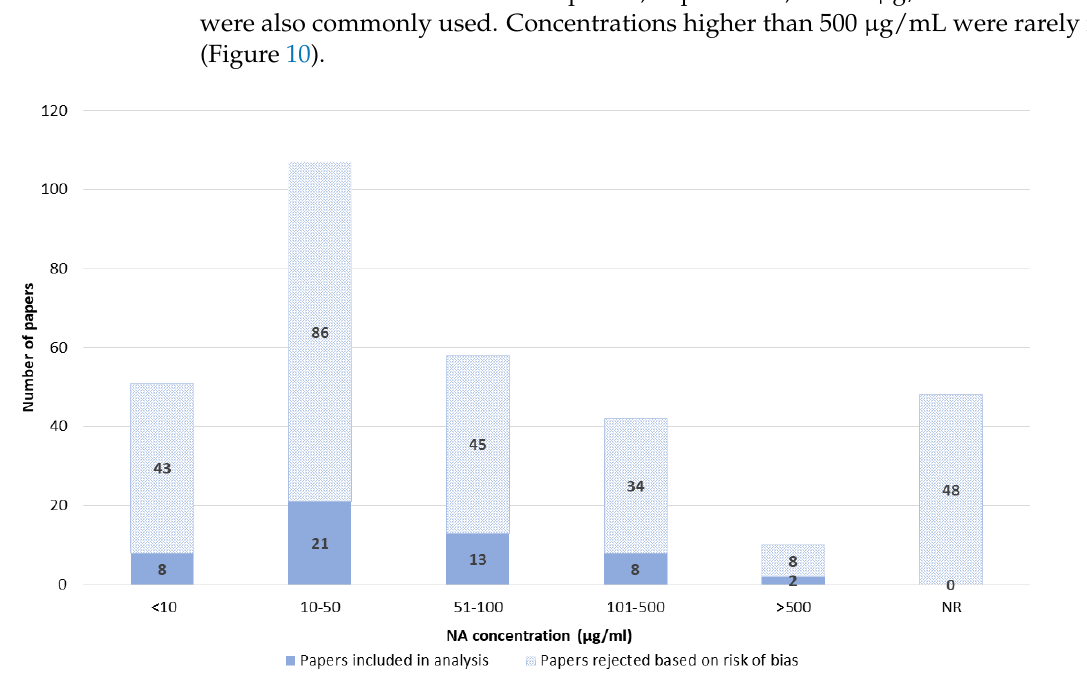
Figure 9. Promoter of NA. NR—not reported.